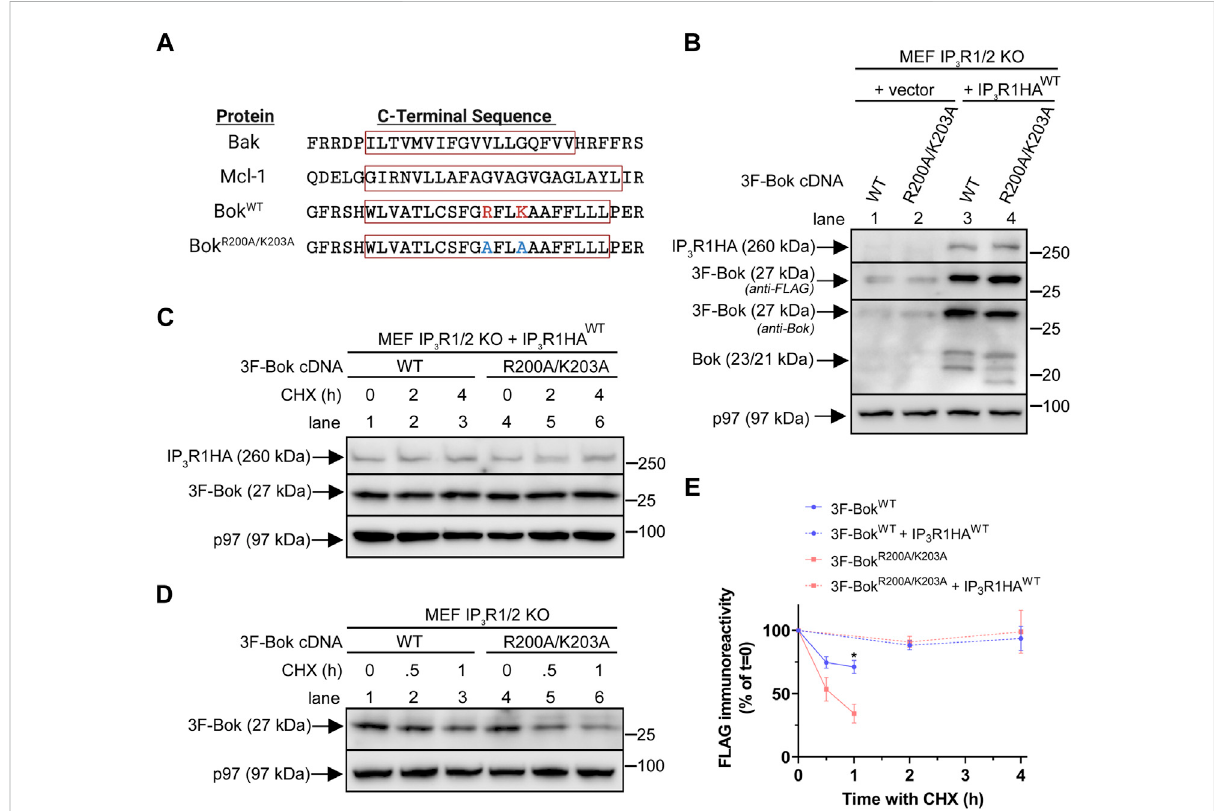
FIGURE 6 Effects of R200/K203 mutation on Bok expression in MEFs. (A) , C-terminal sequences of selected Bcl-2 family proteins with the TM domains enclosed in red boxes (obtained using Uniprot TM domainprediction and TMHMM and Phobius software). R200 and K203 are highlighted inred and alanine mutations are highlighted in blue. The position of the predicted TM domain was identical in both Bok WT and Bok R200A/K203A . (B) , IP 3 R1/2 KO MEFsweretransientlytransfectedwith2 µgof3F-Bokconstructstogetherwith8 µgofemptyvectororIP 3 R1HA WT andsampleswereprobedin immunoblots as indicated. As previously described (Schulman et al., 2016), 3F-Bok WT generates three Bok immunoreactive bands at 27, 23,